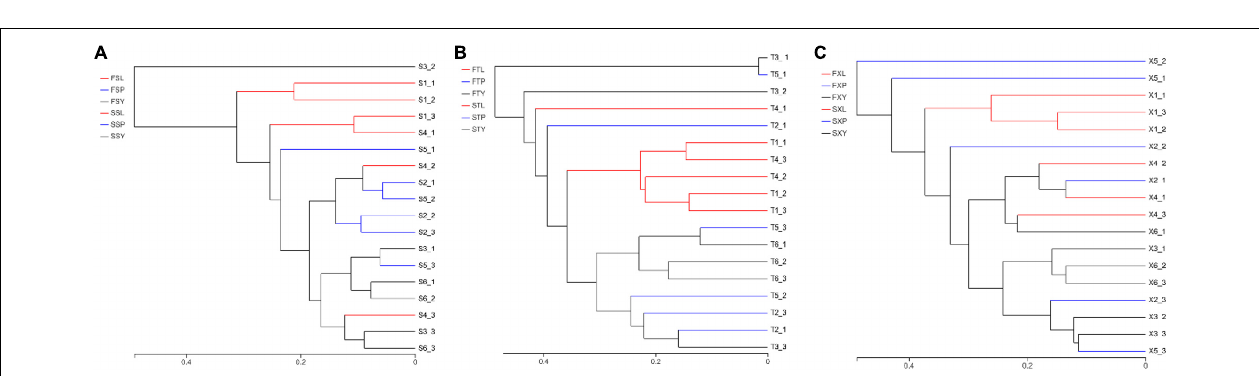
FIGURE 4 | (A) Common endophytic fungi of L. chuanxiong in the first cultivation cycle; (B) Common endophytic fungi of L. chuanxiong in the second cultivation cycle. FL refers to the LZ in the first cultivation cycle; FP refers to the PX in the first cultivation cycle; FY refers to the CX in the first cultivation cycle; SL refers to the LZ in the second cultivation cycle; SP refers to the PX in the second cultivation cycle; SY refers to the CX in the second cultivation cycle.